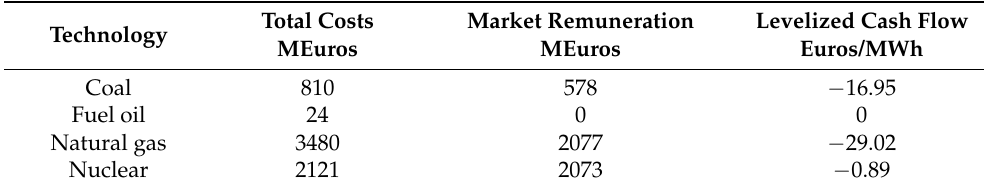
Table 6. Annual total costs, market remuneration and levelized loss of thermal technologies in 2030.